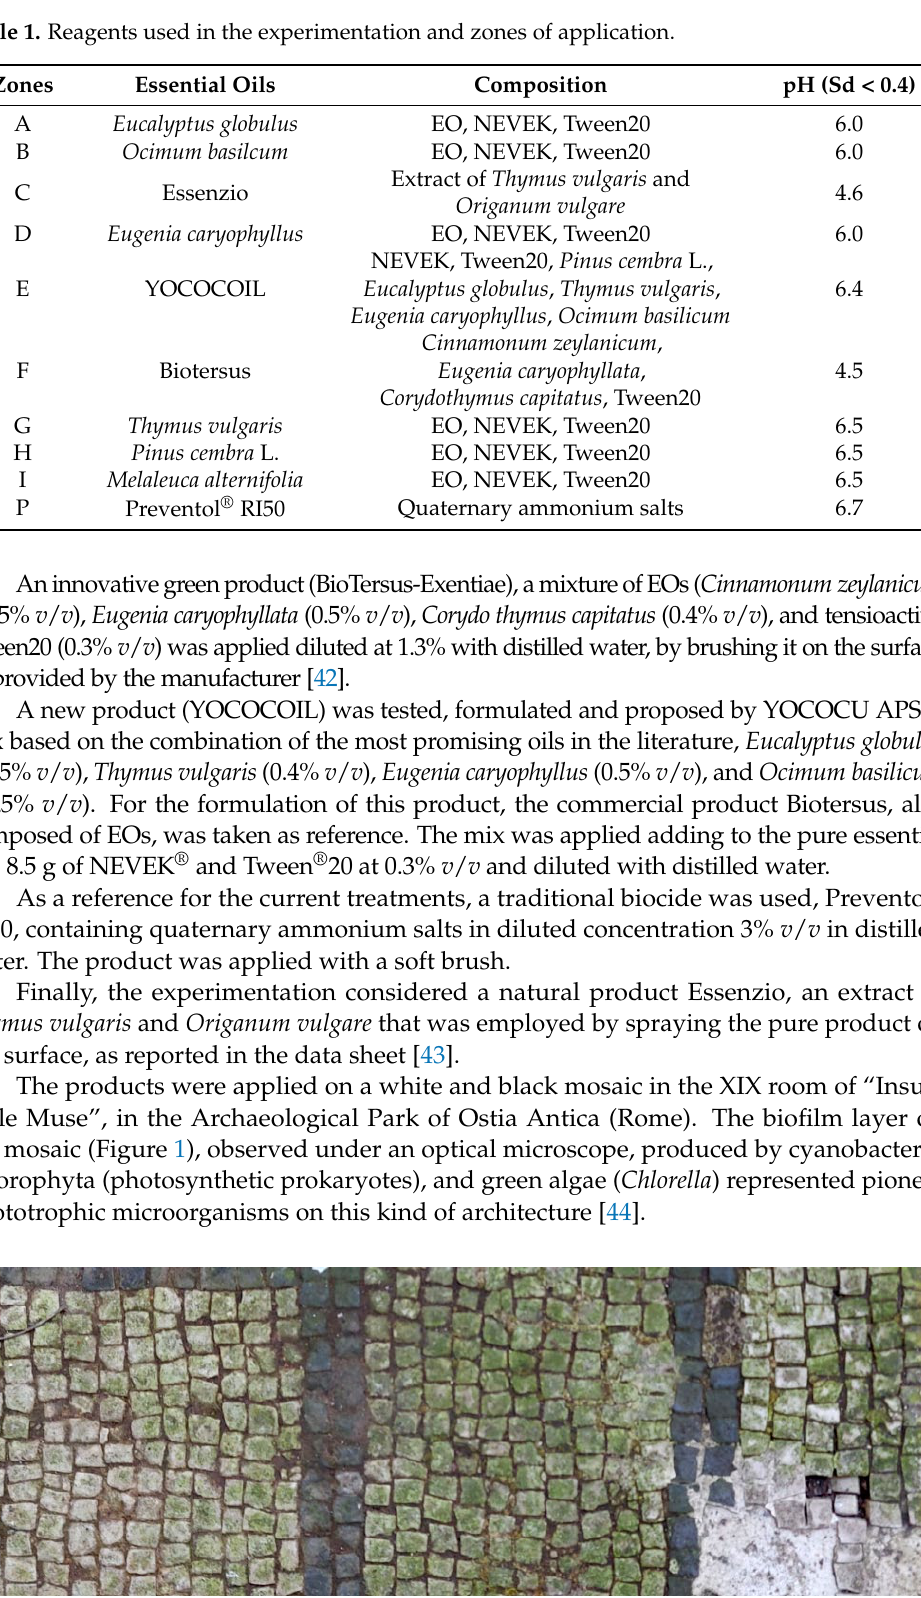
Figure 1. XIX room of “Insula delle Muse”: detail of the biofilm present on the mosaic. Two portions of the mosaic were selected and delimited, respectively in Area 1 and Area 2, characterized by a different level of colonization as shown in Figure 2.